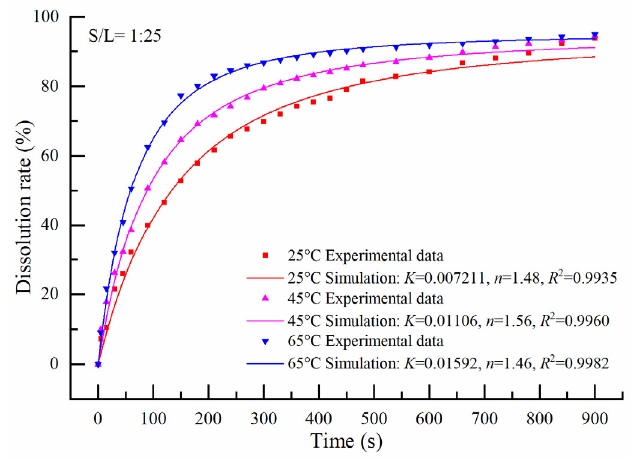
Figure 7. Effects of temperature on chloride ion dissolution rate with S/L ratio of 1:25 and stirring speed of 600 rpm.